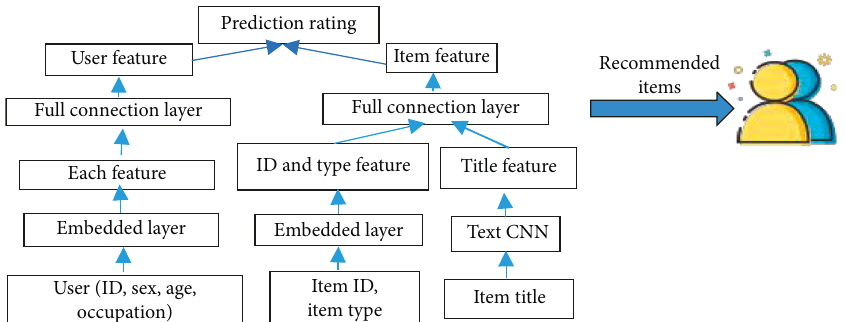
Figure 1: The flow chart of CNN-based recommendation